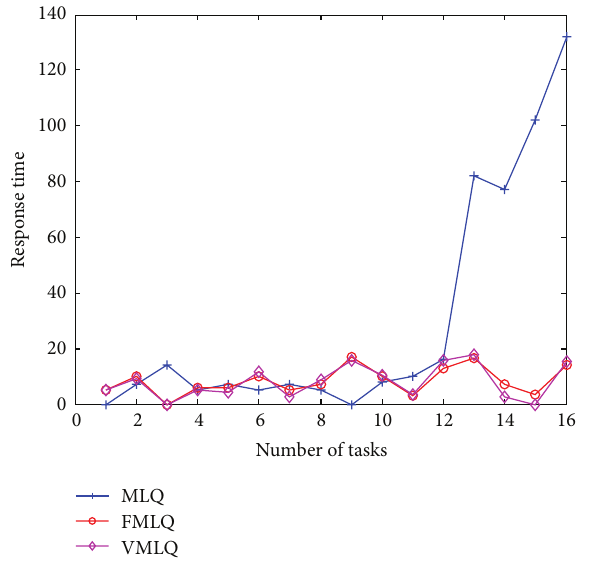
from FMLQ to VMLQ. Dropoff represents the improvement in performance. However, there is slight deviation in average waiting time, average turnaround time, and average normal- ized turnaround time that is acceptable, as response time